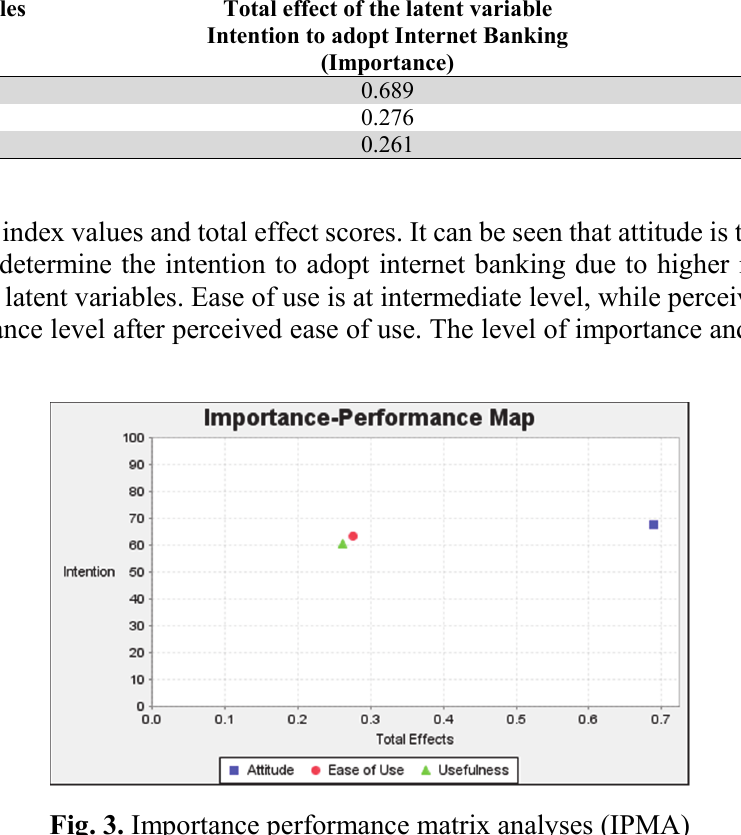
Fig. 3. Importance performance matrix analyses